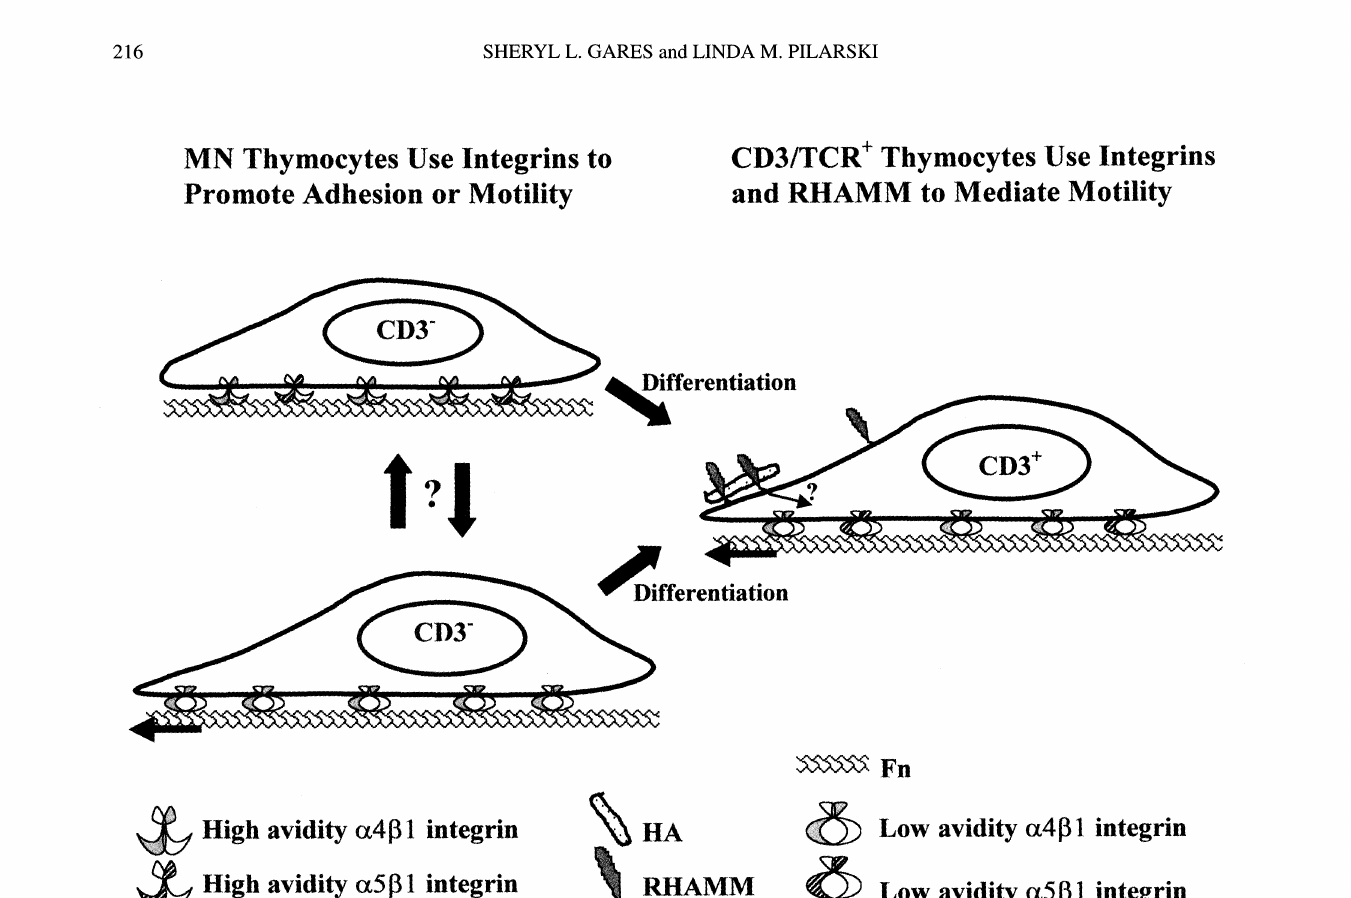
FIGURE 2 Differentiation of MN Thymocytes Correlates With Low Avidity Binding Conformations of 41, c5[1 and Onset of RHAMM Expression. High avidity binding conformations of 4[1 and c5[1 integrins maintain sessile behavior for human MN thymocytes by medi- ating strong binding to the ECM component Fn (as shown) or to stromal cells. 4 integrins in low avidity binding conformations mediate motility for MN thymocytes by mediating weal< adhesive contacts with ECM components. Highly adhesive MN thymocytes might be at a different developmental stage than motile MN thymocytes, but the sequence in development is unknown at this time. As MN thymocytes dif- ferentiate and express CD3 +, they begin to express RHAMM. HA binding to RHAMM mediates motility. Integrins are then maintained in low avidity binding conformations to mediate weak adhesive contacts with the ECM and provide traction for locomoting thymocytes